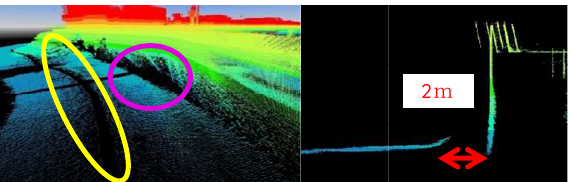
Figure 11. Blank area on